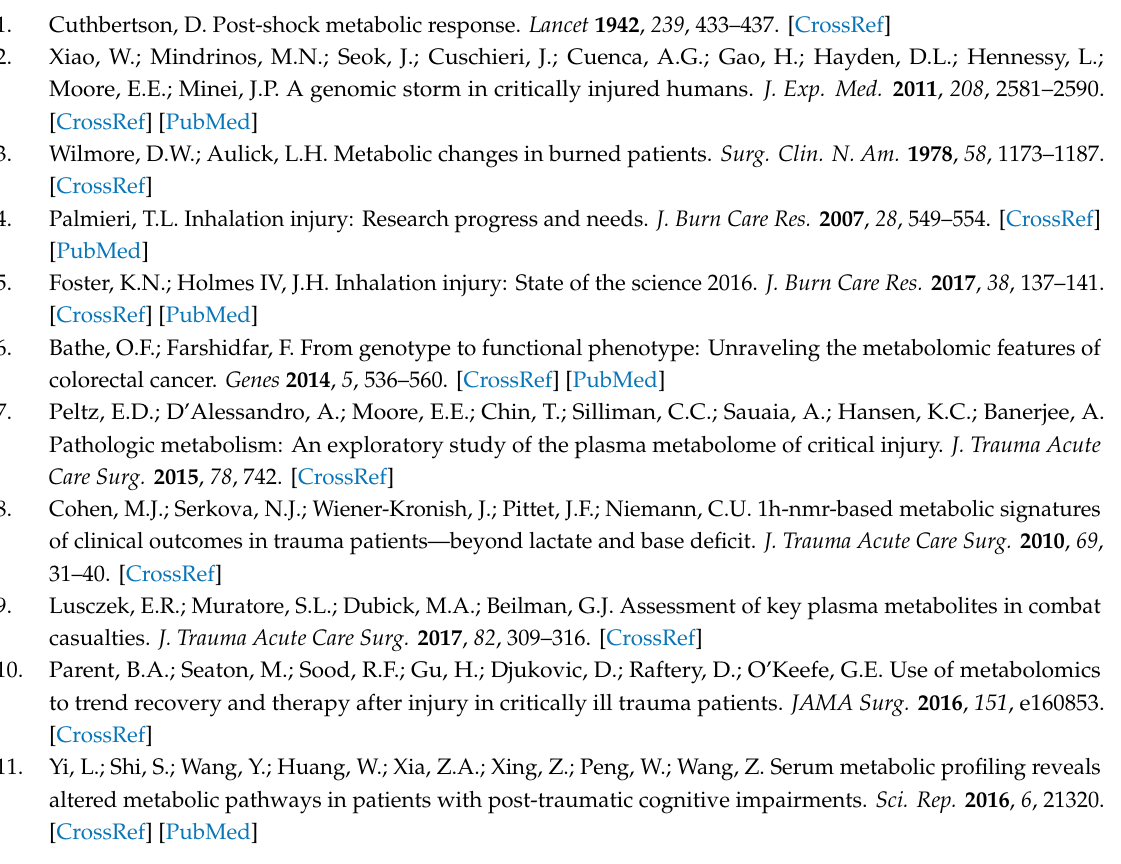
Figure S1: Sample NMR spectrum, Figure S2: Principal component scores for components 1 (PC1) and 2 (PC2) colored by experimental group (black = sham, red = hemoadsorption), Figure S3: Principal component scores for components 1 (PC1) and 2 (PC2) colored by survival (black = lived, red = died); Table S1: Sample Collection by Group and Timepoint., Table S2: Metabolite p -values. Availability of data and materials: